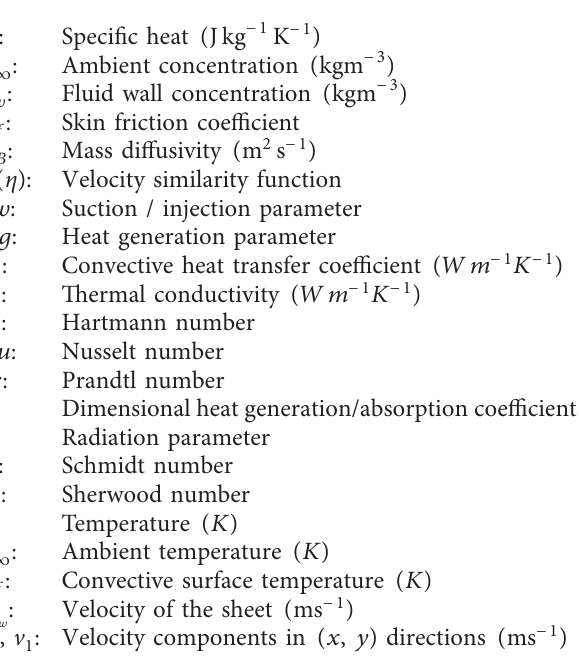
M and (b) c Sc c and c and